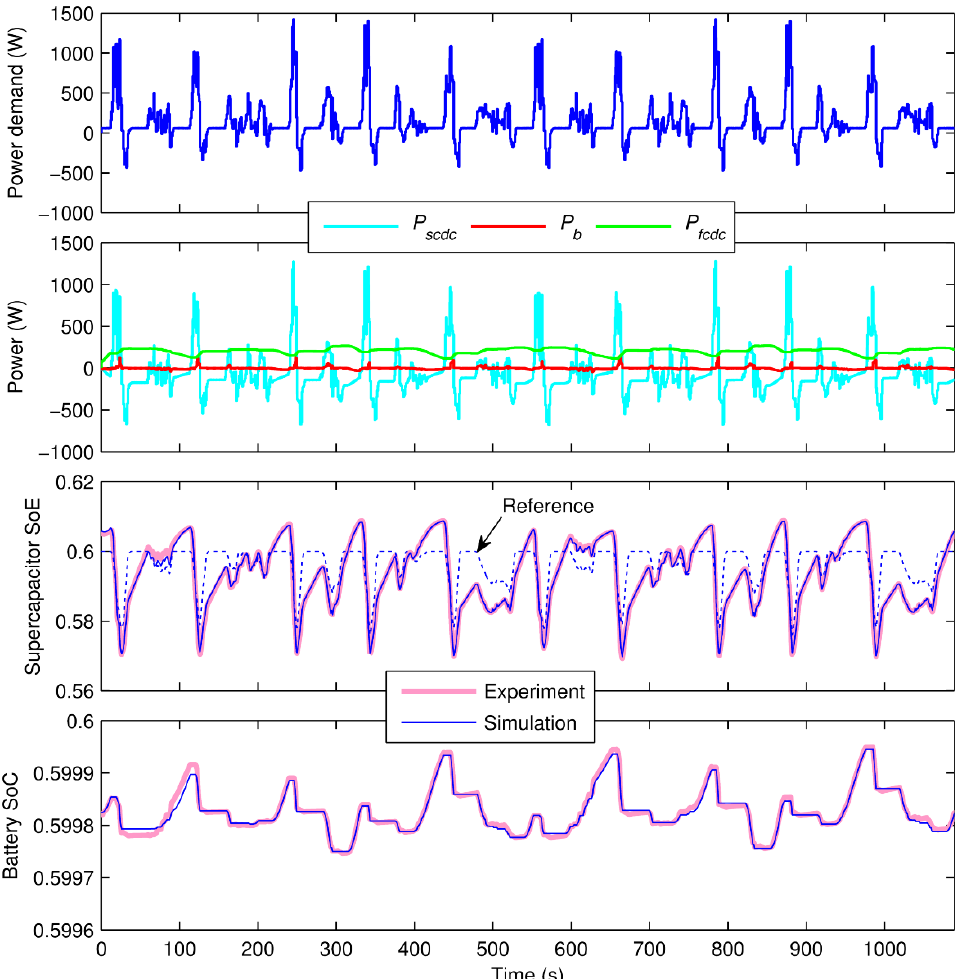
Figure 14. Experimental evaluation of the power management strategy S2 over Manhattan.